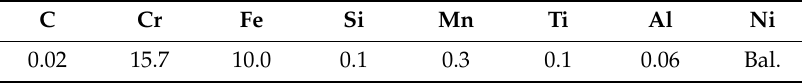
Table 1. Chemical composition of Alloy 600 material (wt.%).